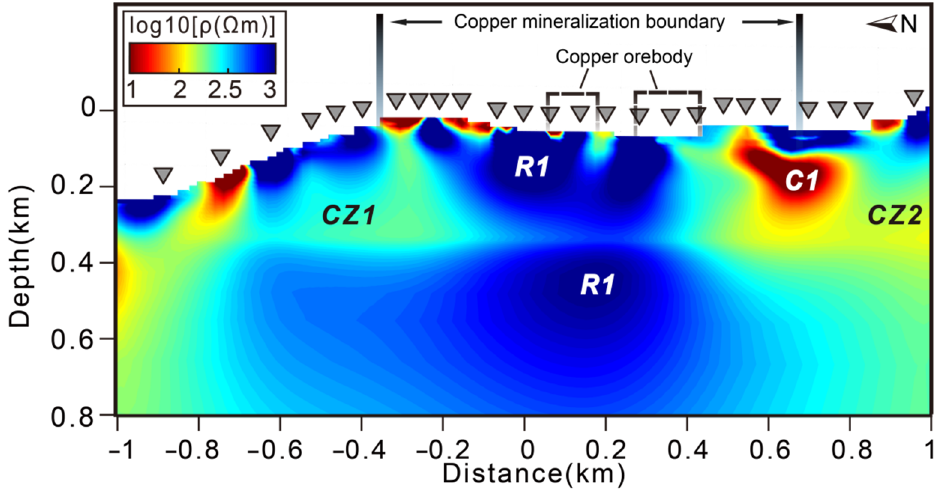
Figure 8. The NW–SE trending vertical slice of the 3D inversion model along the transects shown in Figure 7g. CZ1 and CZ2 are conductive zones. R1 is high-resistivity zone. C1 is a significant con- ductor.